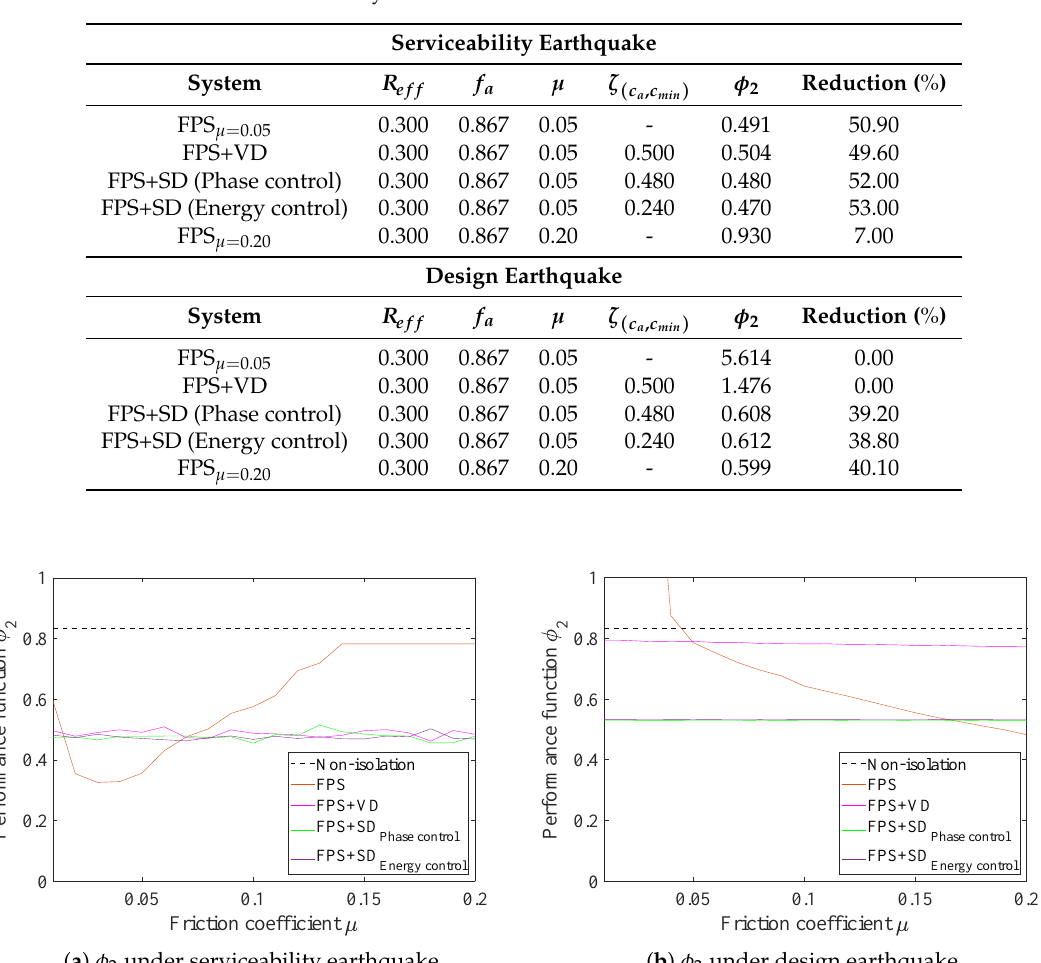
Table 5. Summary of the results for the same effective radius size.